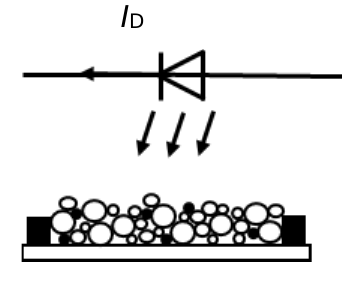
Figure 5. Illustration of resistive gas sensing layer between the terminals (black rectangles) irradiated by UV LED biased by DC I D ; the layer comprises of the grains of different size and dopants of noble metals (black dots) improving gas selectivity.